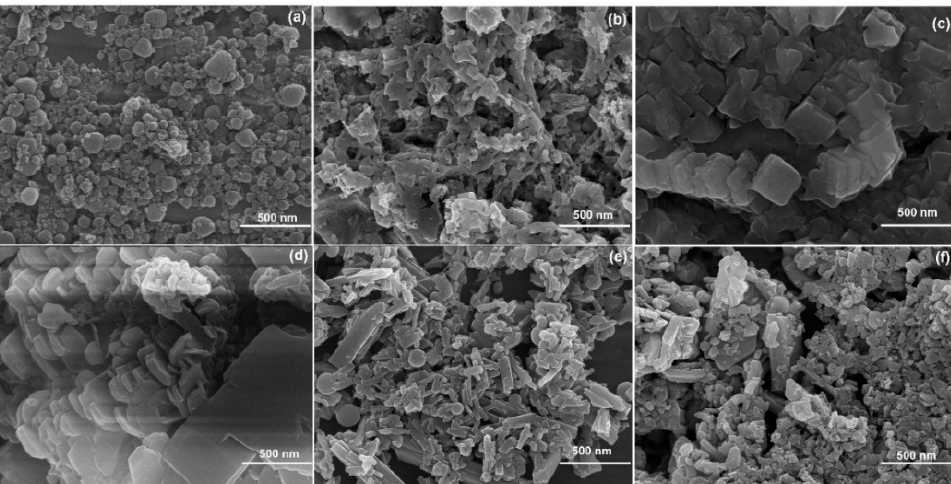
Figure 7. FE-SEM images illustrating the morphology of ionic complexes derived from compound 2 . ( a ) 2 + H 2 CO 3 , ( b ) 2 + HNO 3 , ( c ) 2 + H 2 SO 4 , ( d ) 2 + HCl, ( e ) 2 + CF 3 COOH, and ( f ) 2 + H 3 PO 4 .